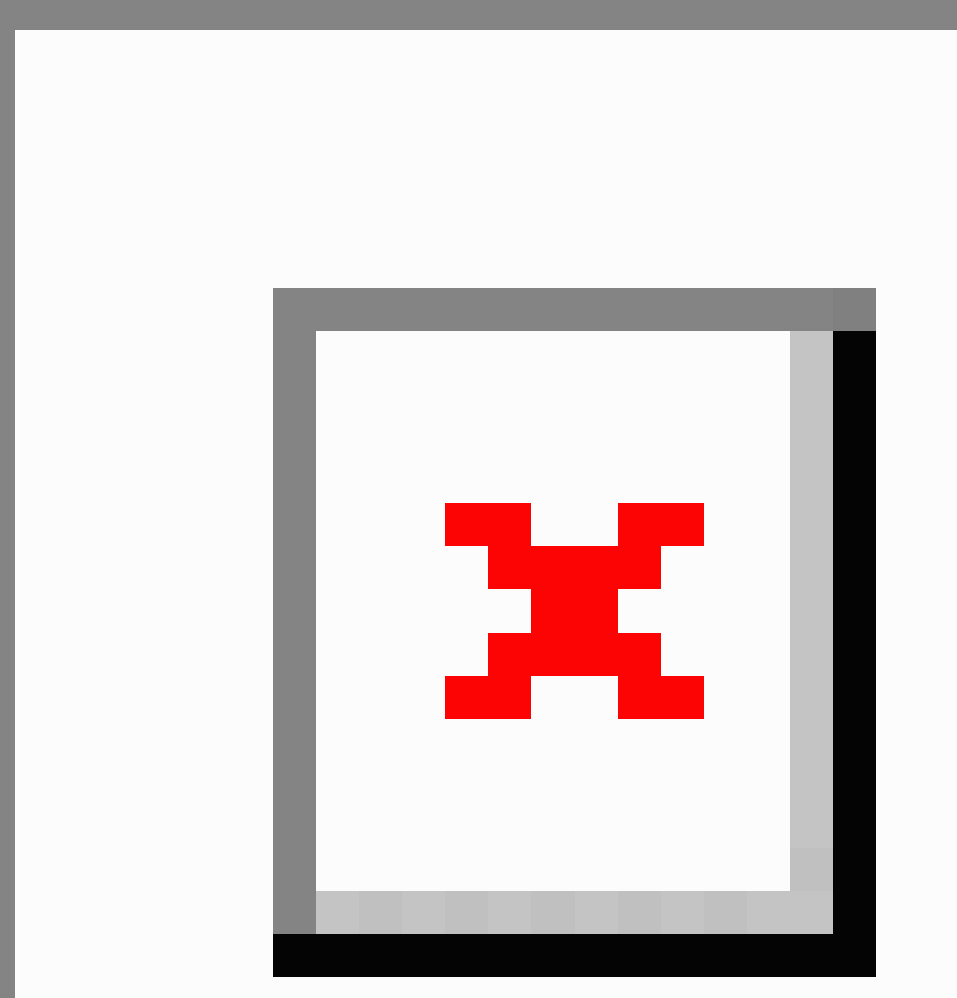
Figure 1. Screenshot of the Amazon Mechanical Turk Web interface for fundus photo